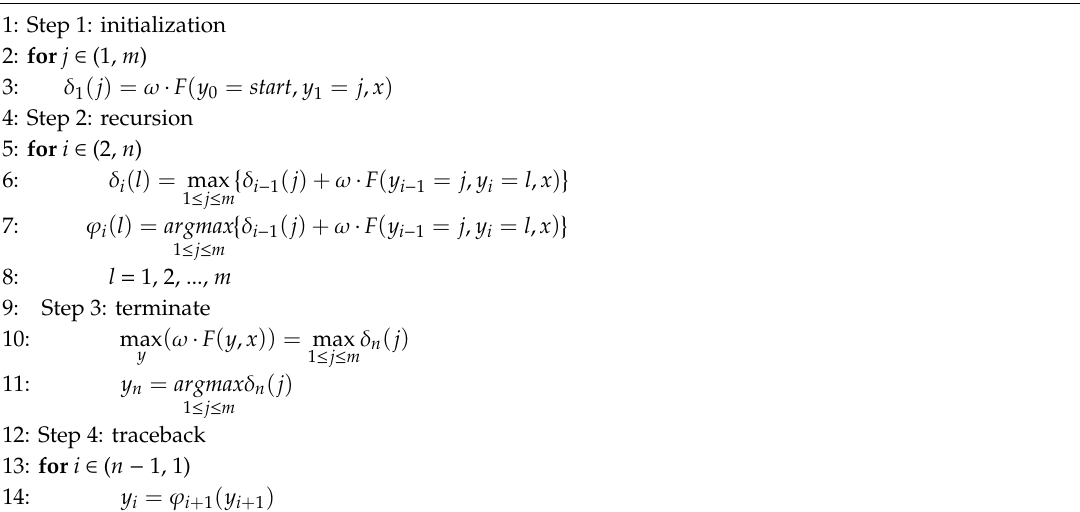
Algorithm 2. Viterbi algorithm for CRF